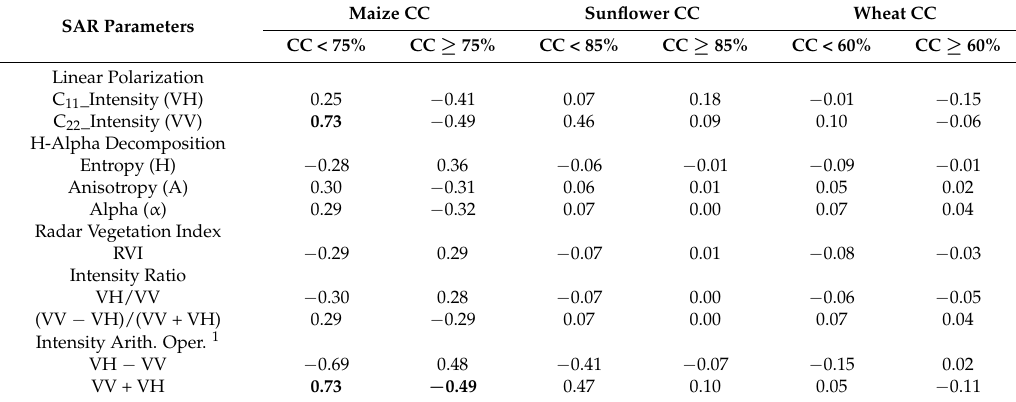
Table 4. Coefficient of determination (R 2 ) between CC and Sentinel-1 SAR parameters.